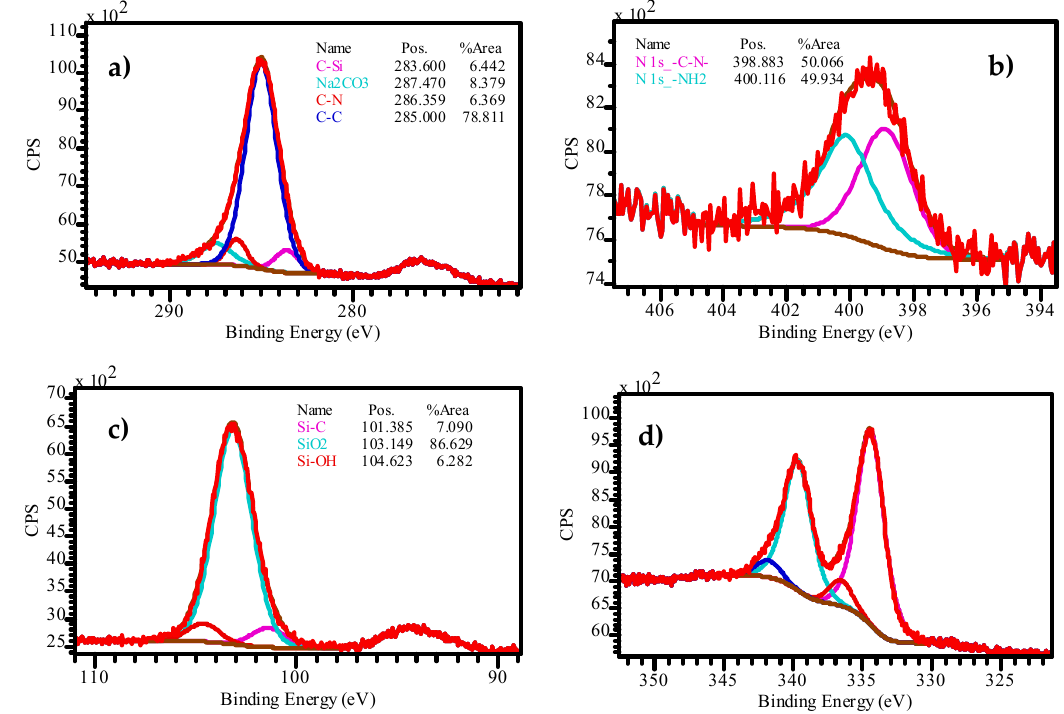
Figure 3. The high-resolution XPS spectra of ( a ) C 1s; ( b ) N 1s; ( c ) Si 2p; energy core-level of SiO 2 -C 3 H 6 -(30%)NH 2 and ( d ) Pd 3d energy core-level of 5% wt. Pd/SiO 2 -C 3 H 6 -(30%)NH 2 .